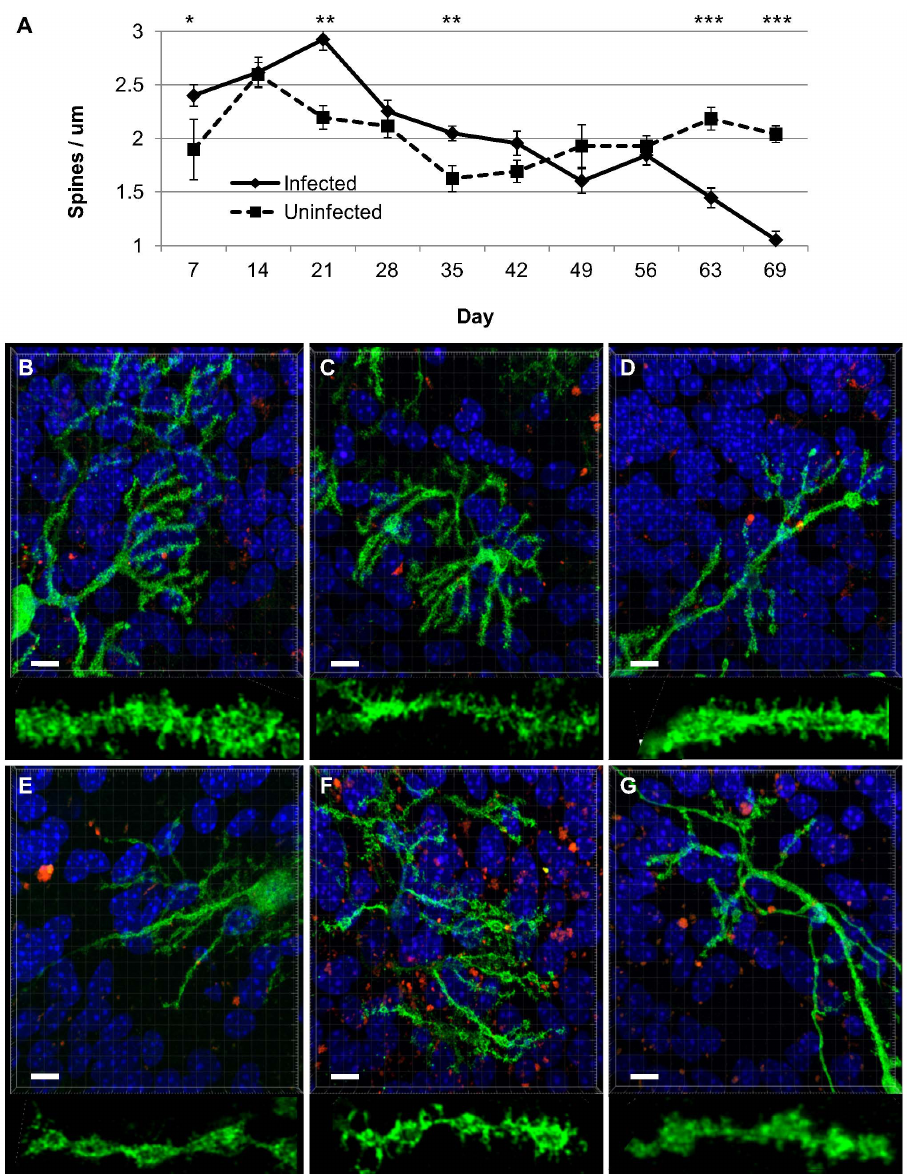
Figure 4. Purkinje cell dendritic spine densities in RML-infected and uninfected cerebellar slice cultures. A) Average Purkinje cell spine densities at weekly time points. B–G) Representative images from uninfected (B–D) and RML-infected (E–G) cultures at day 69. Nuclei are stained with Hoechst (blue), dead cells are stained with propidium iodide (red) and Purkinje cells are labelled with Calbindin/Alexafluor488 (green). Scale bar 10 m m. Insets below each panel are magnified by a factor of three to better visualize dendritic spines. Images of fixed samples were taken on a Zeiss LSM 700, 63x oil objective, deconvolved with ImageQuant X and analyzed using Imaris 7.1.1 software. The average n was 23 per time point for infected (range 12–41), 14 for uninfected (range 6–22). At day 69, n=17 for infected, n=21 for uninfected. p-values: * , 0.05; ** , 0.01; *** , 0.001.